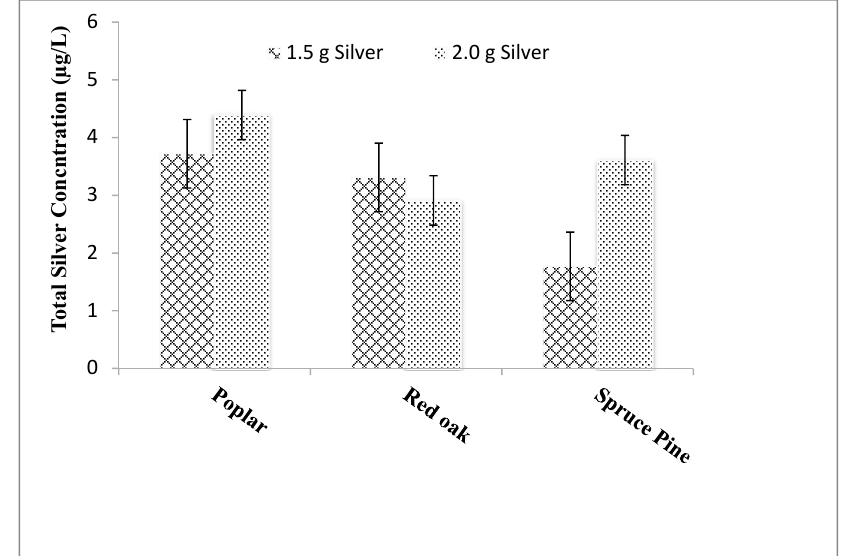
Figure 9. Total silver concentration in 10 L of water for ceramic tablets manufactured with sawdust sourced from different wood and for different masses of silver after a 24 h equilibration period. Error bars represent standard error.